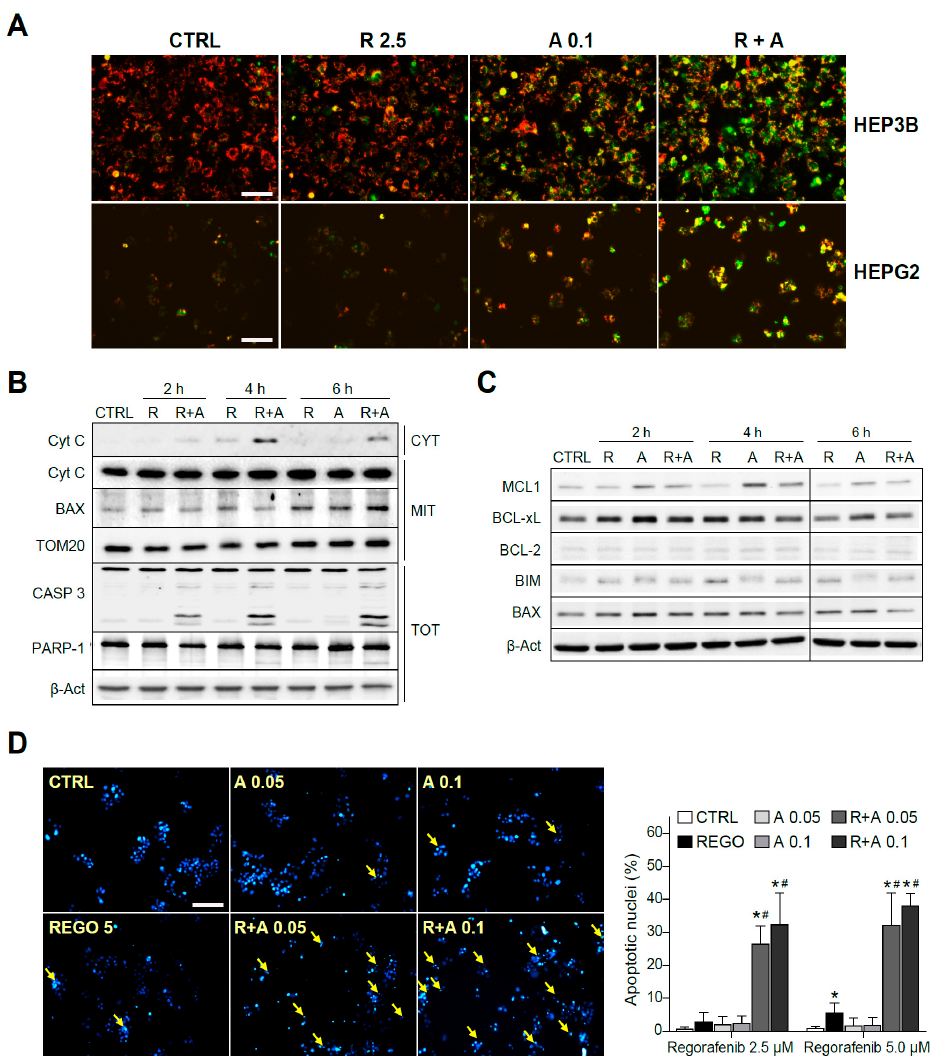
Figure 4. The regorafenib and A-1331852 combination induced apoptotic cell death via a mitochondrial caspase-dependent mechanism. ( A ) Hep3B and HepG2 cells were exposed to regorafenib (R, 2.5 µ M) with or without A-1331852 ( A , 0.1 µ M) and MMP loss observed by fluorescence microscopy after 3 h (scale bar, 100 µ m). ( B ) Cytochrome c release, BAX and TOM20 mitochondrial levels, caspase-3, PARP-1, and β -Actin were analyzed by Western blot in HepG2 cells. ( C ) BCL-2 proteins in cell extracts as above. ( D ) Nuclear Hoechst 33258 staining was visualized in HepG2 cells treated with regorafenib and / or A-1331852 (scale bar, 100 µ m), and apoptotic cells counted (10 independent fields per condition, n = 3). * p < 0.05 vs. control cells, # p < 0.05 vs. regorafenib-treated cells.